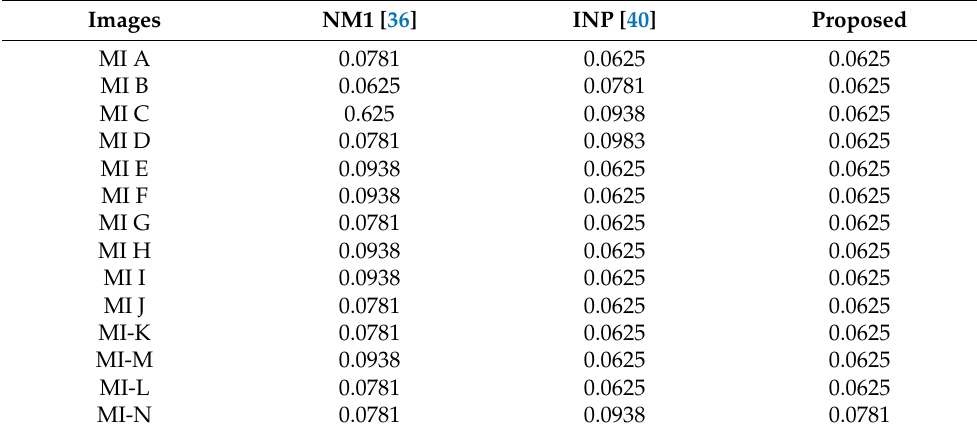
Table 2. Comparison of CI Generation Time in